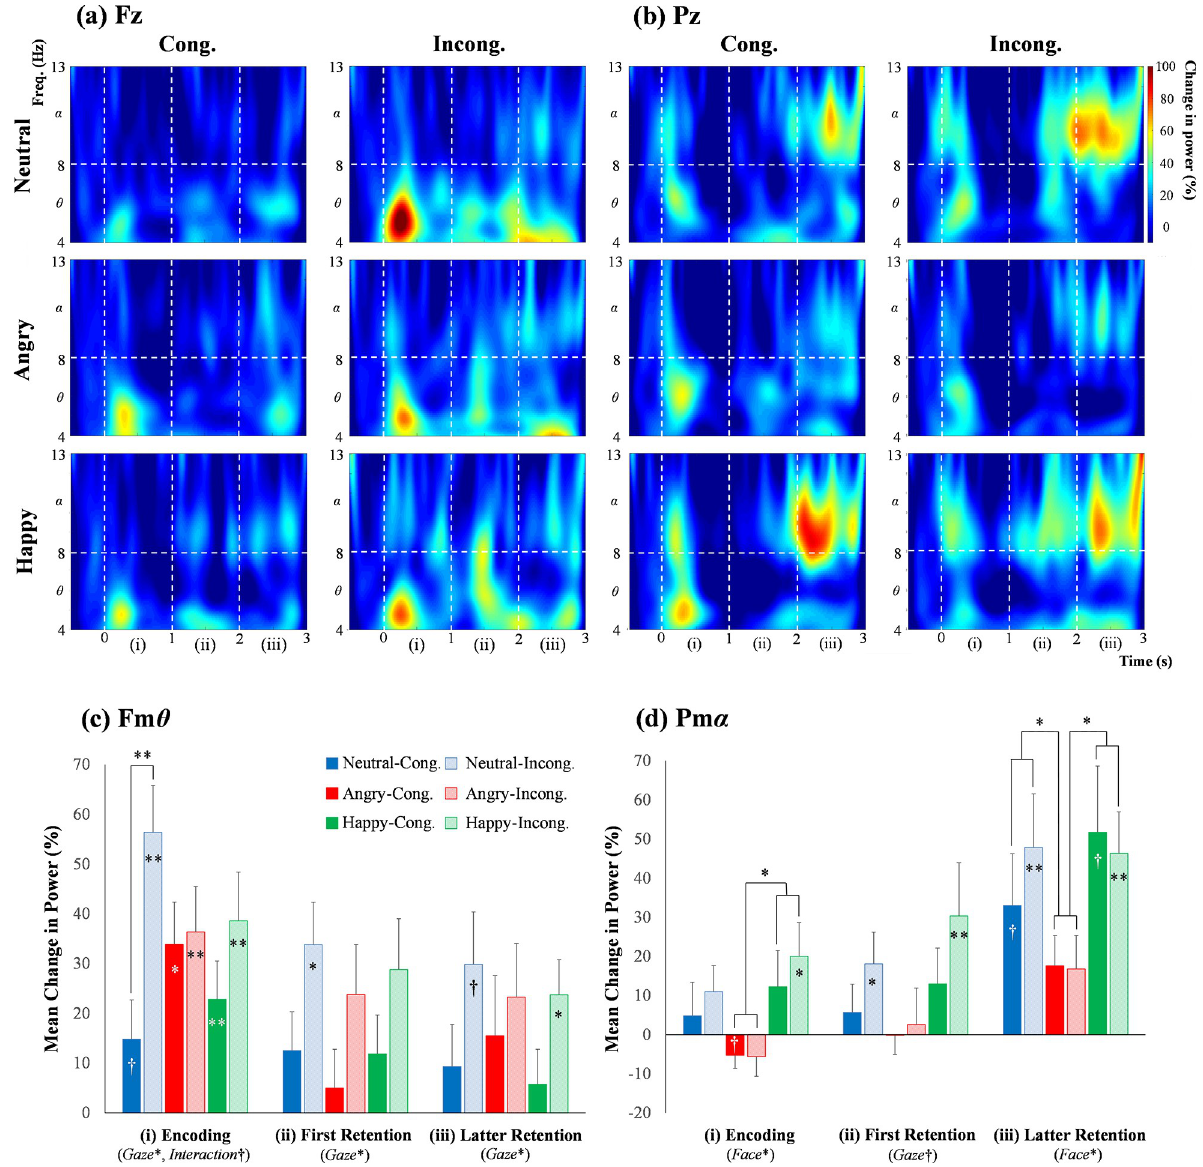
Fig 3. Time-course changes in the induced θ and α powers at (a) Fz and (b) Pz sites during the working memory task for preschool children: (i) encoding and decision period, (ii) first retention period, and (iii) latter retention period. The average data with statistics for the (c) Fm θ and (d) Pm α powers in each period. The symbols in squares ( �� , p < .01; � , p < .05; † , p < .1), nonparametric tests versus baseline values; those in brackets, the ANOVA